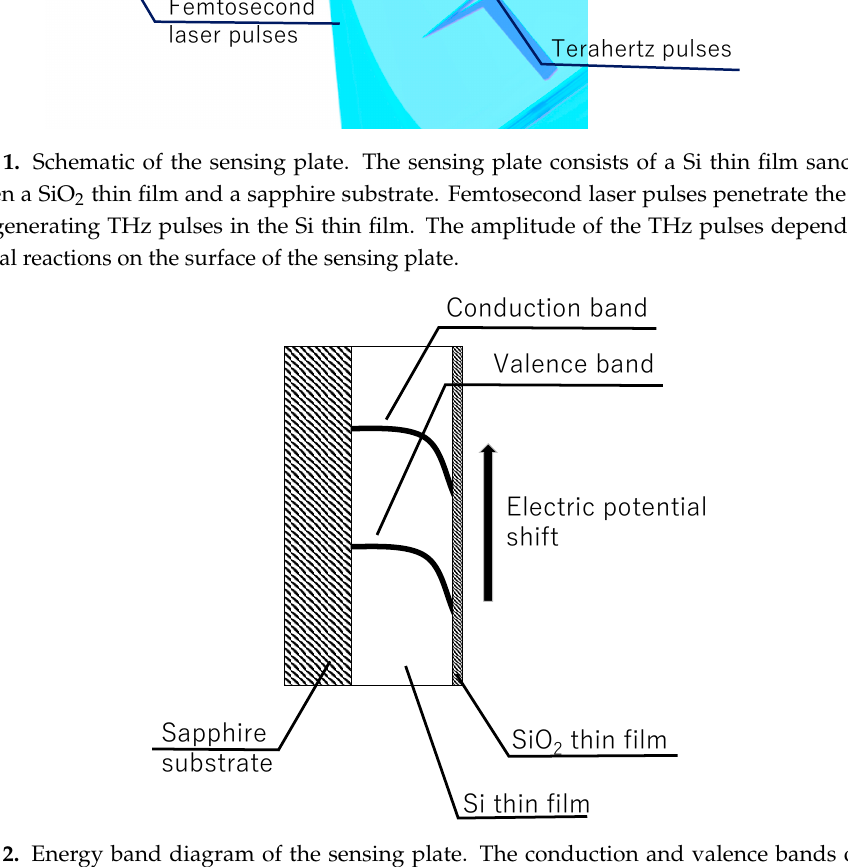
Figure 2. Energy band diagram of the sensing plate. The conduction and valence bands of the Si thin film are slightly bent near the Si–SiO 2 boundary, forming a natural depletion field near the edge of the Si film. When a chemical reaction shifts the electric potential on the sensing-plate surface, it simultaneously changes the magnitude of the depletion field.